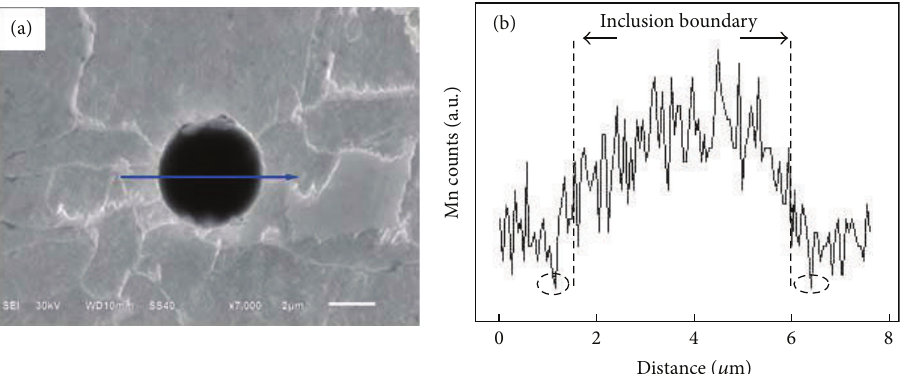
Figure 5: (a) The SEM image of inclusion, which induces the formation of intragranular acicular ferrites. (b) Line EDS analysis of Mn along the nucleation site of inclusion and surrounding steel